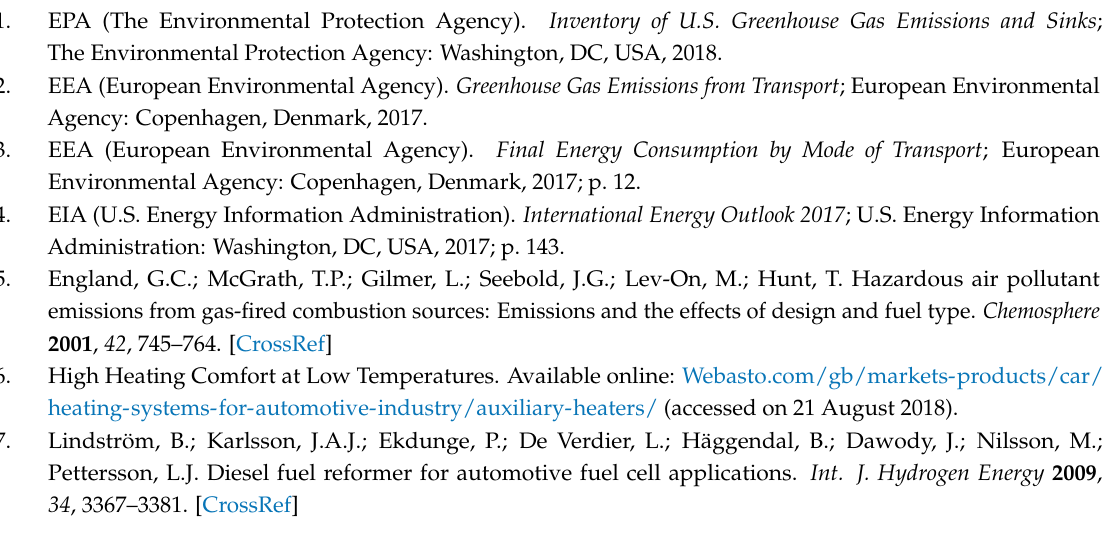
s1, Figure S1: velocity streamlines around the mixing plate, Figure S2: velocity rendering results by changing the location of the ring cone, Figure S3: liquid length for different air swirl numbers, Figure S4: contours of temperature profiles for different air swirl numbers, Figure S5: contours of evaporating droplets for the smallest nozzle diameter, Geometry S1: geometry file in Ansys workbench format, Geometry S2: geometry file in IGS workbench